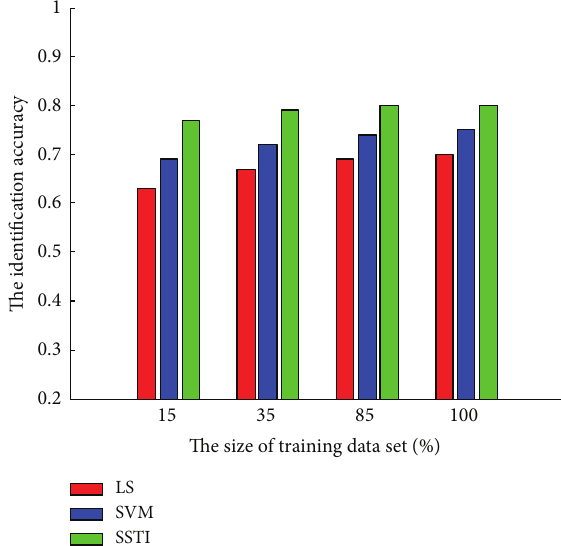
Figure 3: Sentiment identification on microblog messages.